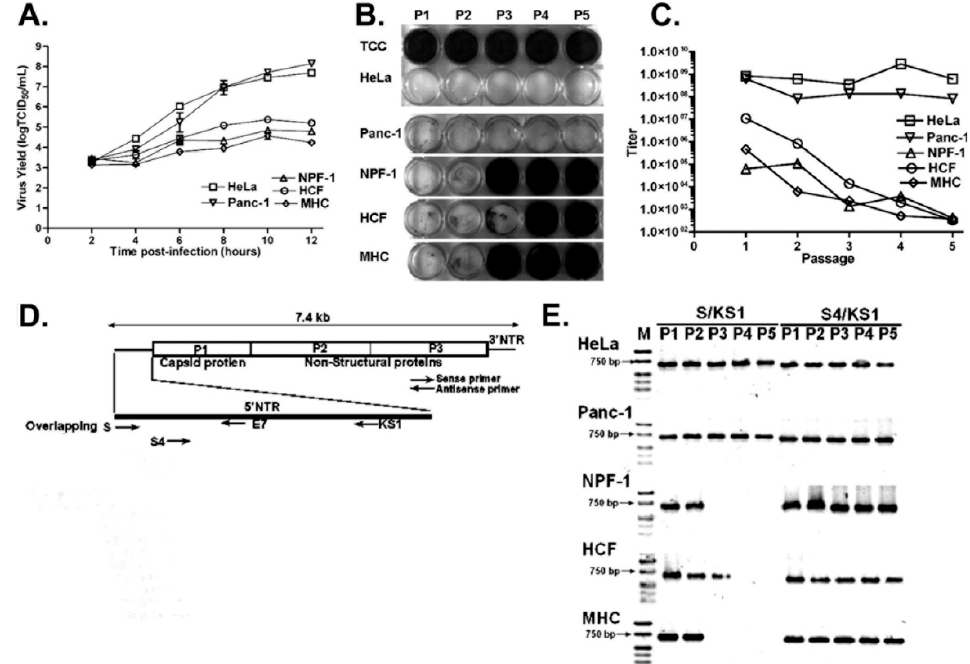
Figure 3. CVB3 replicates, but does not induce, CPE in the indicator HeLa cell monolayers following sequential infection of replication-restricted primary cells. ( A ) Single-step growth curves of CVB3/28 in primary cell cultures NPF-1, MHC, and HCF, and in immortal cell lines HeLa and Panc-1 (inoculated with an MOI of 20 TCID50 per cell). Error bars show standard deviations. ( B ) Supernatants of CVB3/28 passaged in primary cell cultures lose the ability to cause CPE in HeLa cell monolayers. P1 to P5, HeLa cells infected with supernatants of passages 1 to 5; TCC, uninfected HeLa cell control. Cell cultures were fixed in acetic acid/acetone and then stained with crystal violet. Titers at each passage were determined either by CPE on HeLa cell monolayers or by real-time quantitative RT-PCR. ( C ) Titers from serial passages shown in panel B are plotted. ( D ) Relative positions in the CVB3 genome of primers used in this study. ( E ) CVB3/28 RNAs in primary cell cultures detected by RT-PCR. Lane M, Hi-Lo DNA marker (Minnesota Molecular, Inc., Minneapolis, MN); lanes P1 to P5, passages 1 to 5. Arrows indicate 750 bp bands. Reprinted with permission from [61], 2008, American Society for Microbiology.